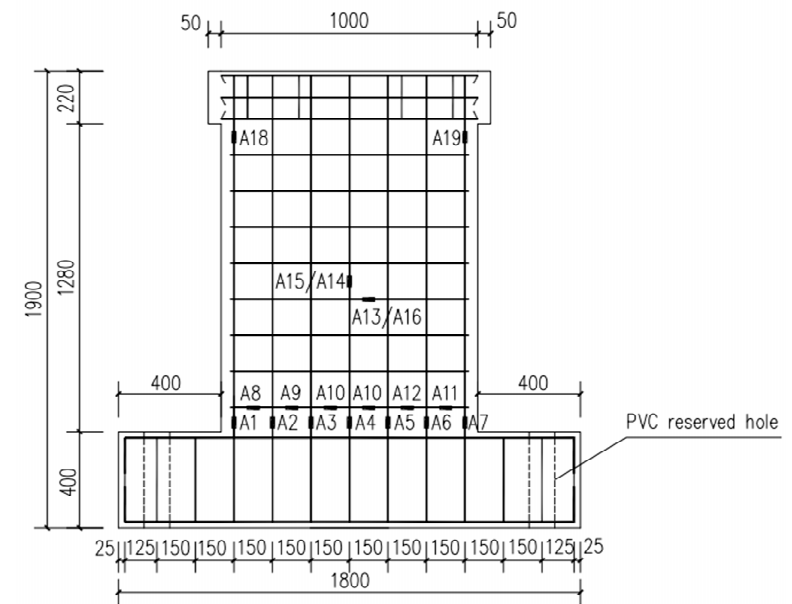
Figure 5. Layout diagram of steel strain gauge.